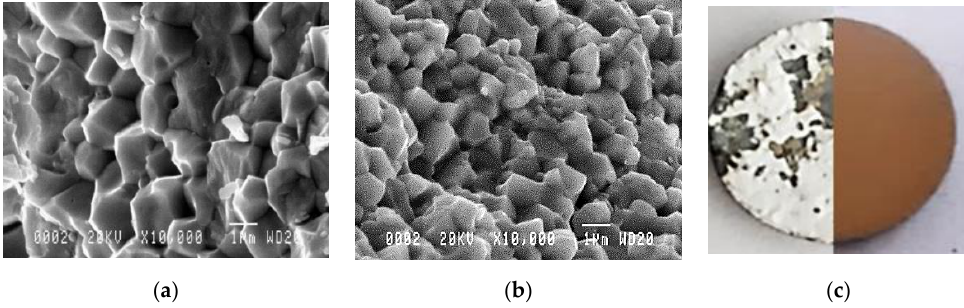
Figure 8. SEM images of fractured PZT ceramics sintered by spark plasma sintering (SPS) at 875 °C without a sintering aid: ( a ) Without a protective layer and ( b ) with SrCO 3 . ( c ) Elimination of the SrCO 3 layer by etching or polishing.